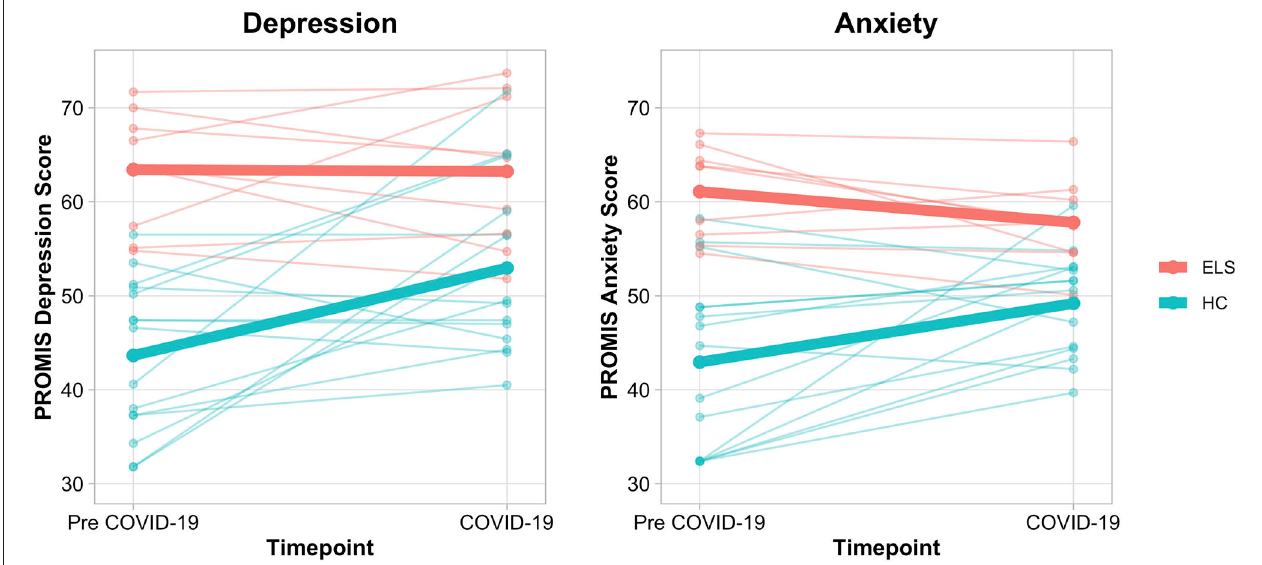
FIGURE 2 | Spaghetti plots depicting self-reported depression and anxiety in healthy controls and early life stress exposed adolescents. Means for each group are depicted via a bolded line. A significant Group by Time Interaction was found for the LME models examining depression [ F (1, 22) = 4.54, p = 0.045, d = 0.91] and anxiety [ F (1, 22) = 9.35, p = 0.009, d = 1.23]. HC subjects demonstrated meaningful increases in depression and anxiety ( t = 3.43, p = 0.003, d = 1.07; t = 3.10, p = 0.005, d = 0.81), while ELS subjects did not ( t = − 0.05, p = 0.96; t = − 1.25, p = 0.222). ELS, early life stress; HC, healthy control; LME, Linear Mixed-Effects Model; PROMIS, Patient-Reported Outcomes Measurement